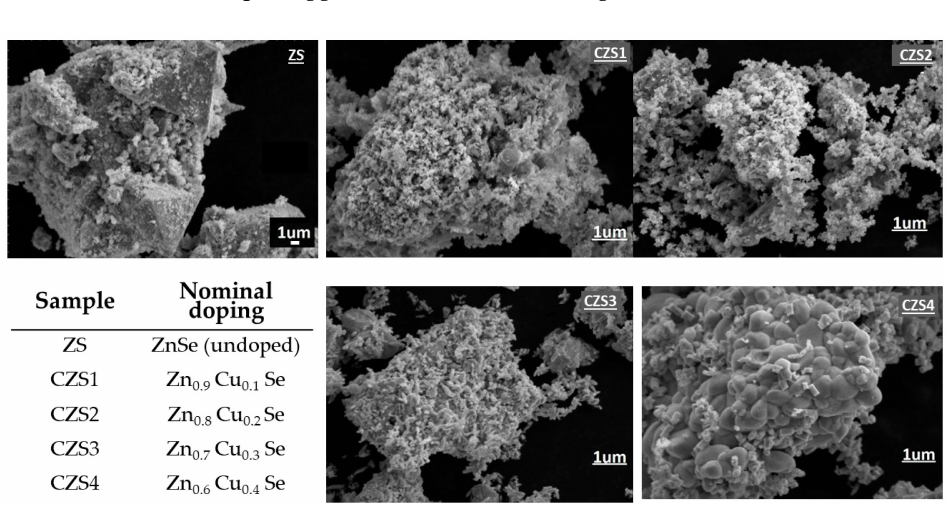
Figure 3. Scanning electron micrographs of the prepared Cu 2+ doped ZnSe